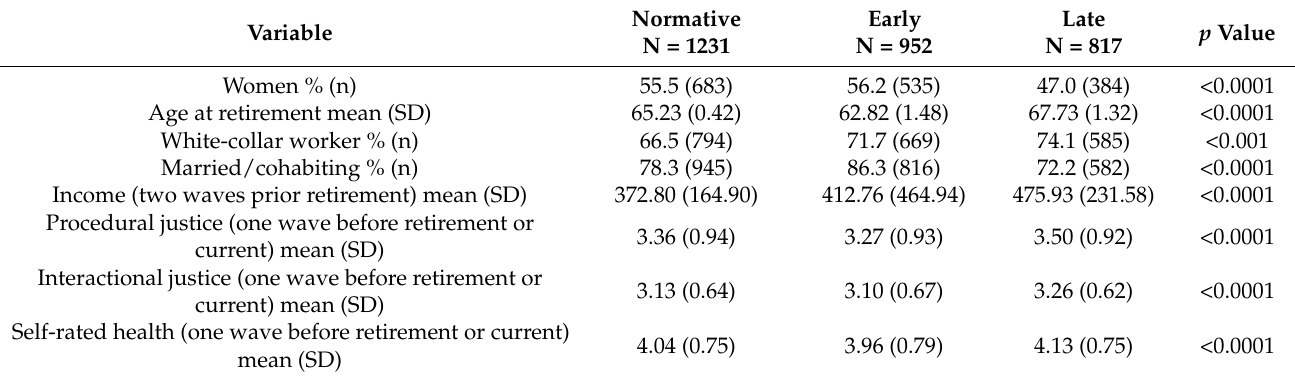
Table 2. Description of retirement